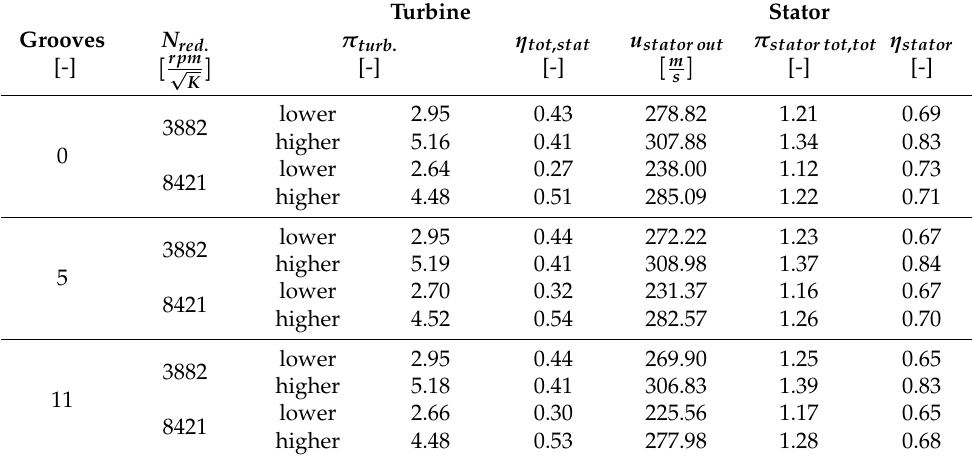
Table 5. Pressure ratio and performance of the turbine and stator for the evaluated cases with and without grooved surface; URANS